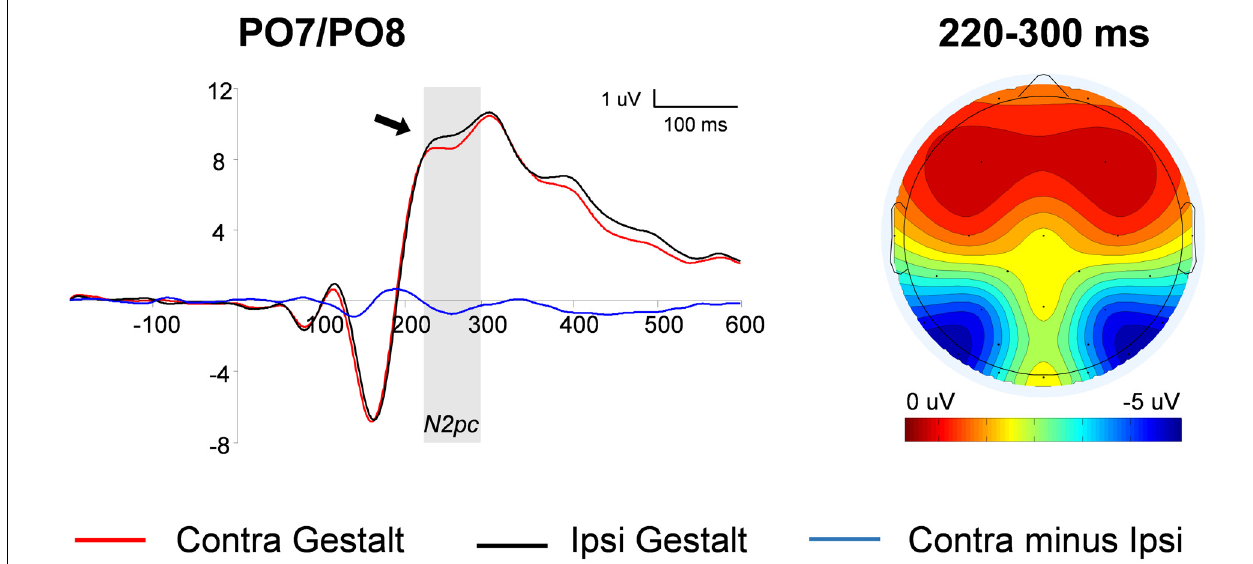
FIGURE 3 | N2pc analysis: waveforms and voltage maps. Average ERP (event-related potentials) waveforms of the N2pc component measured at parieto-occipital (PO) locations contralateral to Gestalt stimuli (red line) and ipsilateral to Gestalt stimuli (i.e., contralateral to non-Gestalt; black line), on trials with unilateral Gestalt configuration (Gn and nG). The blue line represents the N2pc difference wave (red line minus black line). The arrow indicates a significant effect and the shaded gray area indicates the time-windows in which the significant effect was found. The map on the right shows the average voltage map relative to the N2pc difference wave within the 220–300 ms